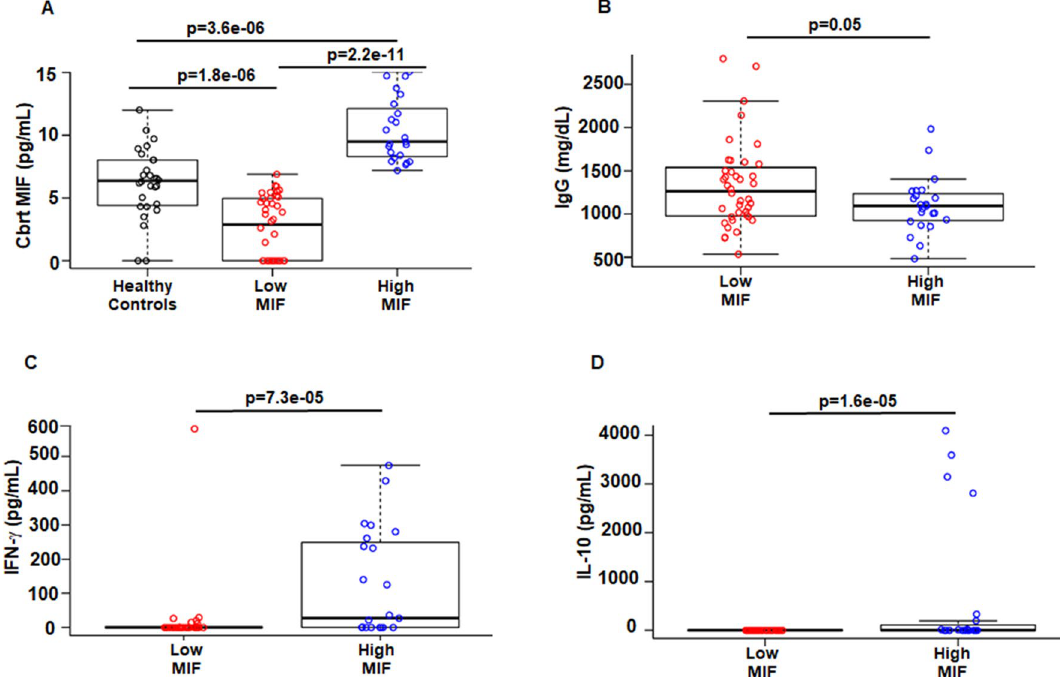
Figure 2. Classification of sarcoidosis patients based on serum MIF levels. Boxplots illustrate median values and interquartile range of each marker. Sarcoidosis patients with serum cbrt MIF values of less than 7.18 pg/ mL were classified as low serum MIF subgroup, whereas MIF higher than 7.18 pg/mL were classified as high MIF subgroup. Healthy controls had significantly higher levels of MIF ( p = 1.8e−06) as compared to low MIF subgroup, high MIF subgroup had significantly higher levels of MIF as compared to healthy controls ( p = 3.6e−06) and low MIF subgroup ( p = 2.2e−11) ( A ). Boxplot depicts the differences of median and interquartile range in serum IgG based on MIF subgrouping. Low serum MIF-group exhibited significant higher levels of serum IgG ( p = 0.05) as compared to high MIF subgroup ( B ). Boxplot depicts the differences of median and interquartile range of serum IFN-γ. High serum MIF-group exhibited significantly higher levels of serum IFN-γ ( p = 7.3e−05) ( C ). Boxplot depicts the differences of median and interquartile range of serum IL-10 between sarcoidosis MIF subgroups. Median values in low-MIF group were significantly ( p = 1.6e−05) higher ( D ). p value < 0.05 was considered to be